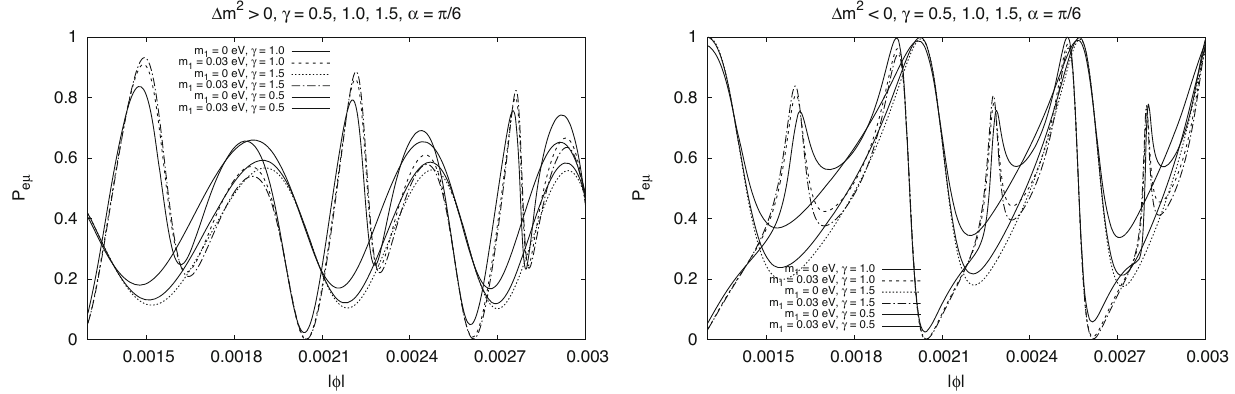
Fig. 4 Left panel: neutrino oscillation probability as a function of azimuthal angle φ for γ = 1 . 0, 0 . 5 and 1 . 5 with (cid:8) m 2 > 0 (nor- mal hierarchy). Here the solid line represents m 1 = 0 eV and γ = 1 . 0, the dashed line represents m 1 = 0 . 03 eV and γ = 1 . 0, the dotted line represents m 1 = 0 eV and γ = 1 . 5, the dotted-dashed line represents m 1 = 0 . 03 eV and γ = 1 . 5, the thick solid line represents m 1 = 0 eV and γ = 0 . 5, and the triple-dotted dashed line represents m 1 = 0 . 03 eV and γ = 0 . 5. Right panel: neutrino oscillation probability as a function